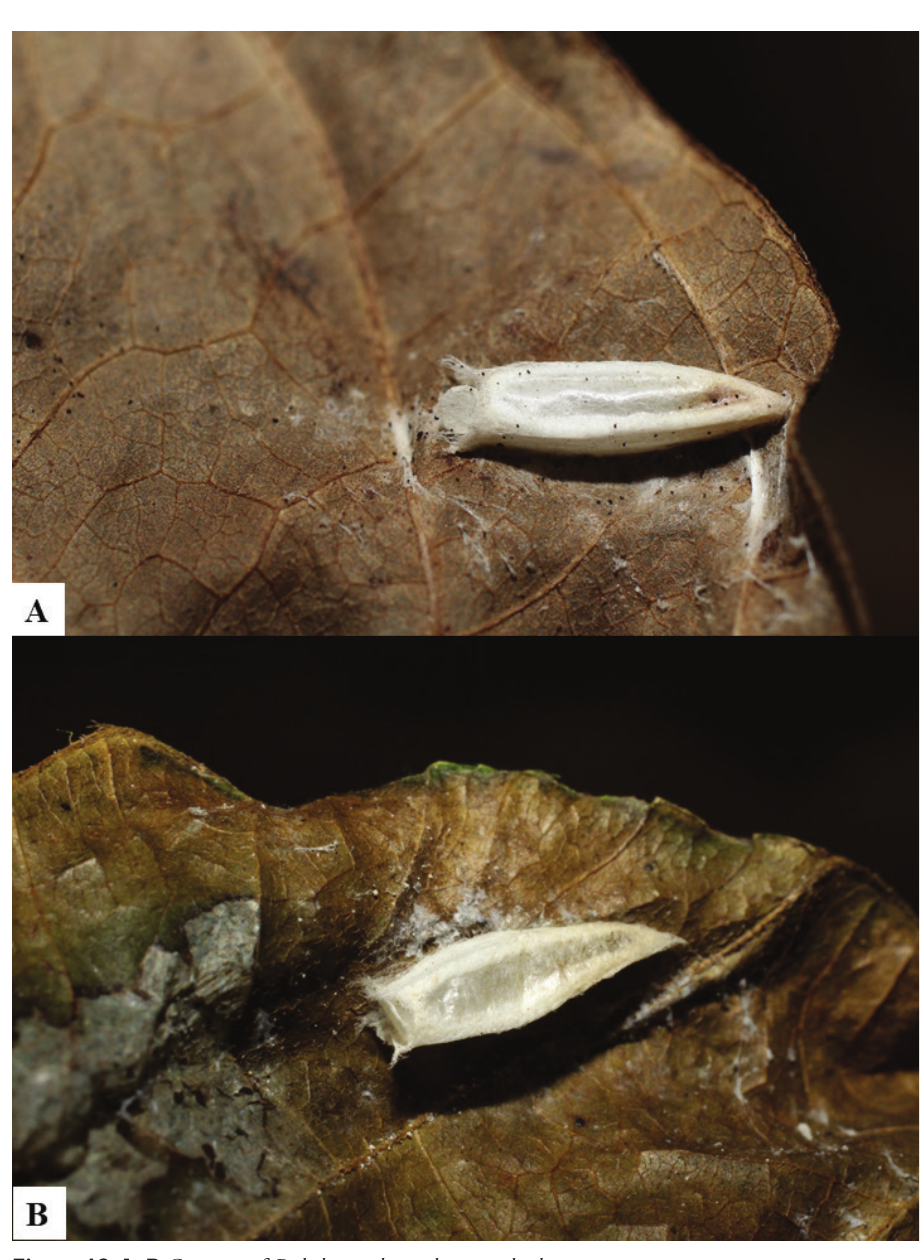
Figure 12. A, B Cocoons of Dolichogenidea carlosmanuelrodriguezi sp.